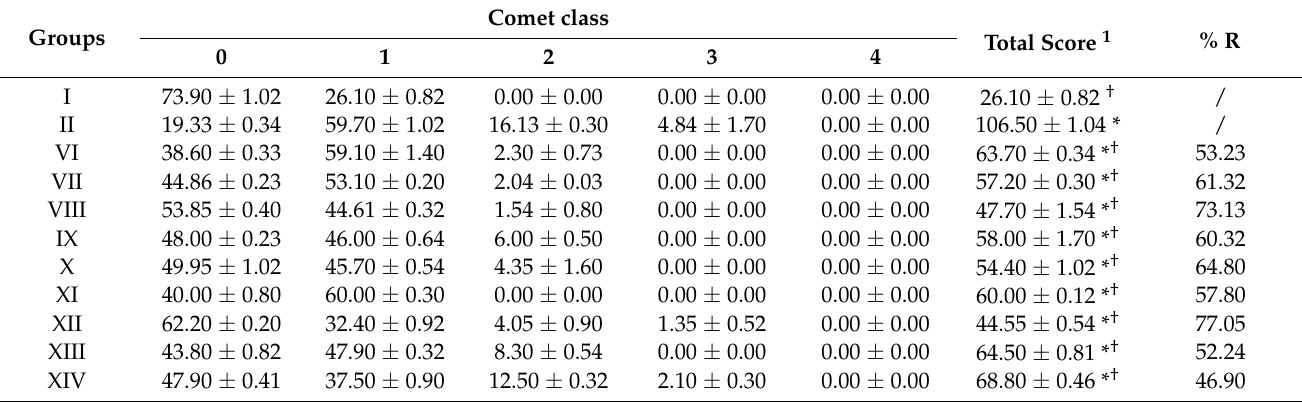
Table 7. DNA damage in livers of rats exposed to CCl 4 and different doses of N. cataria extracts. Groups